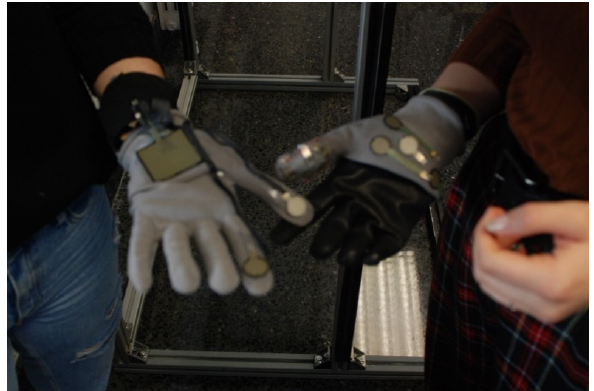
Figure 18. Participants from Group 2 making the physical prototype. Sensors 2020 , 20 , x FOR PEER REVIEW 24 of 29